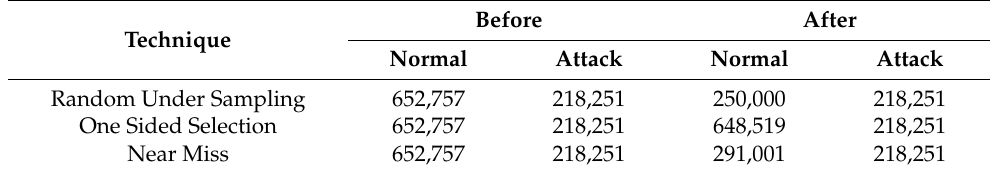
Table 5. Balancing the CICIDS2017 dataset with